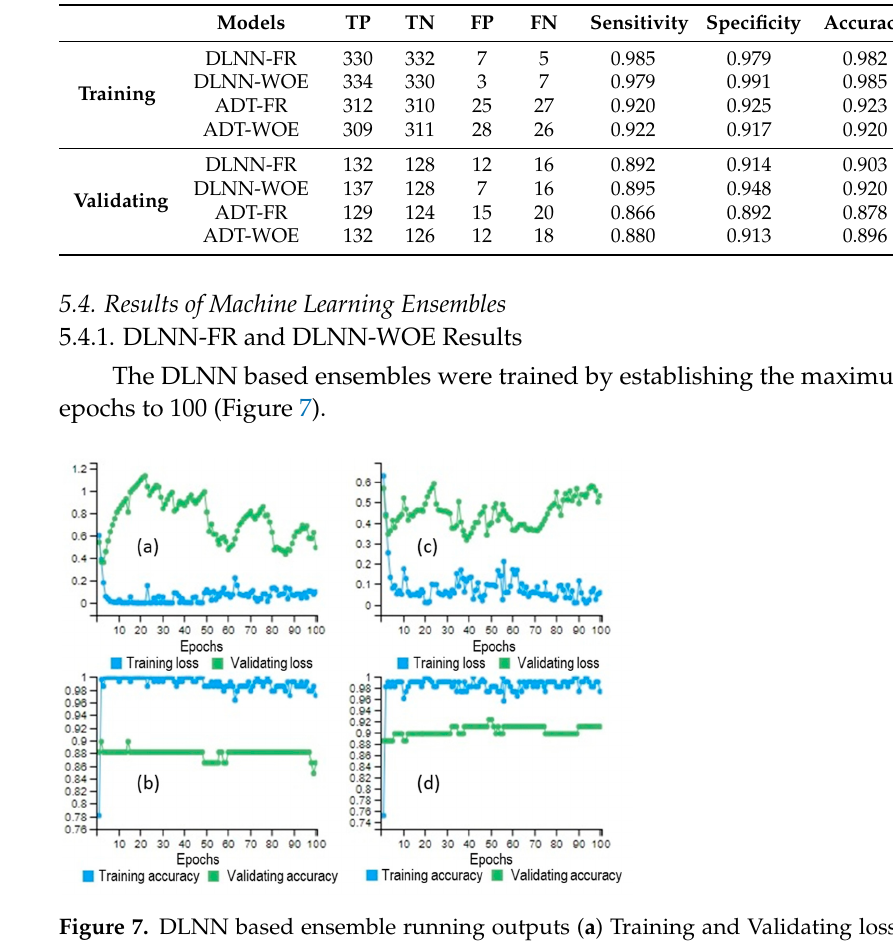
Table 3. Statistical metrics used to evaluate model’s performance.